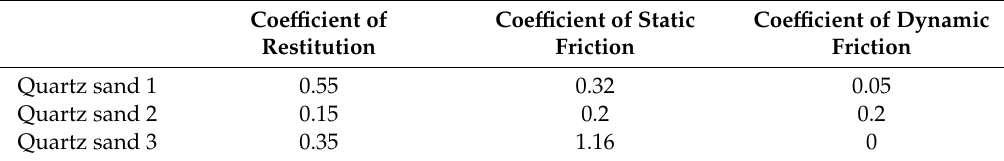
Table 3. The interaction parameters between particles of three kinds of quartz sand. Coefficient of Coe ffi cient of Static Coe ffi cient of Dynamic Restitution Friction Friction Quartz sand 1